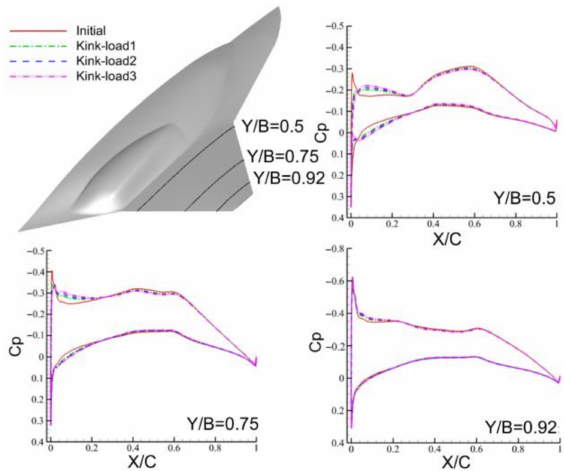
Figure 19. The positions and pressure coefficient distributions at typical sections of the different fore-loaded configurations. Ma = 0.85, α = 2 ◦ .